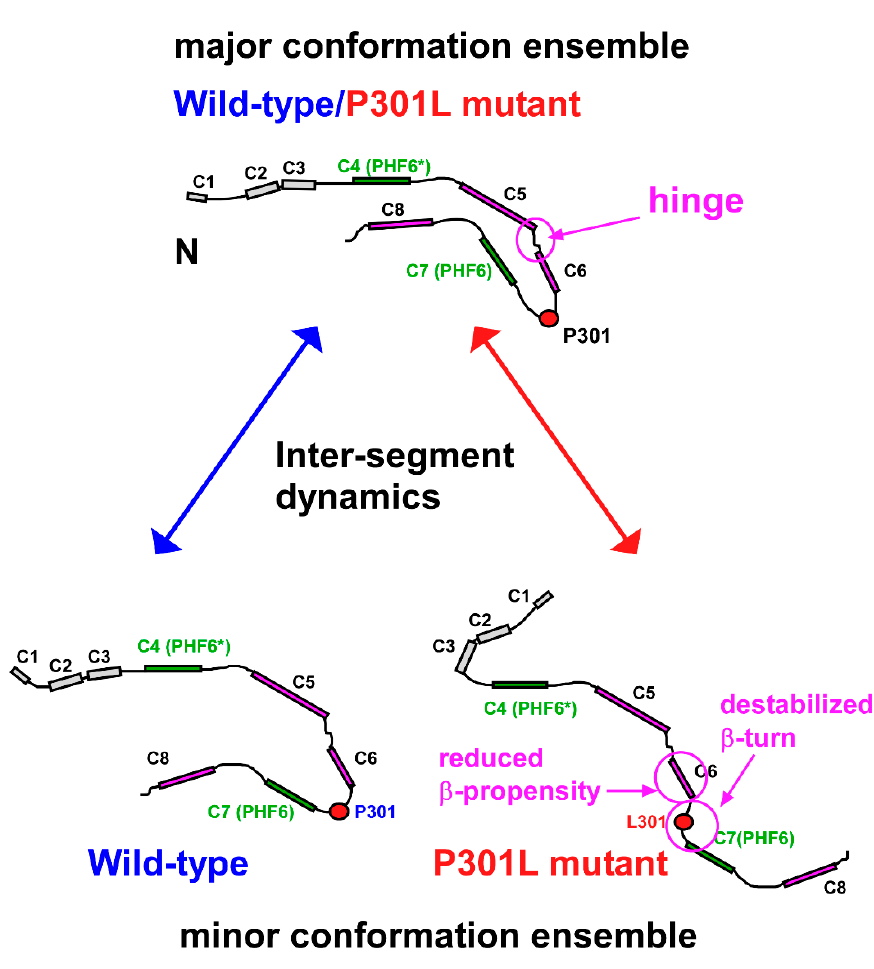
Figure 8. TauF4 Δ segmental conformation dynamics determine the ensemble structures. The boxes represent segments that comprise residues that are undergoing correlated motions, which were identified on the PRE maps (Figure 4). Each label of the box indicates the corresponding segment name on the PRE maps. Residues in the segments C4–C8 closely overlap with residues in the β -structures ( β 1– β 5). Segments corresponding to the amyloid motifs, PHF6* and PHF6, are green and other segments are purple. The conformations in the major ensembles of the wild-type and P301L mutant TauF4 Δ should resemble each other, as indicated by the similar PRE maps (Figure 4). The P301L mutation destabilizes the β -turn structure of 301 PGGG 304 causing this region to adopt an extended structure preferentially. The conformational dynamics of the hinge linking C5 and C6 segments may further promote the extended form populations of the P301L mutant; the dynamic nature of the hinge was shown by the higher values of R 2 / R 1 (Figure 2C). The PRI-derived model structure of the wild-type TauF4 Δ has moderately exposed PHF6, while the model for the P301L mutant largely exposes the amyloid motif, PHF6. The conformational ensemble switch explains the enhanced aggregation propensity of the P301L mutant. The disrupted inter-segment dynamics by the P301L mutation may facilitate conformational ensembles that differ from those of the wild-type.